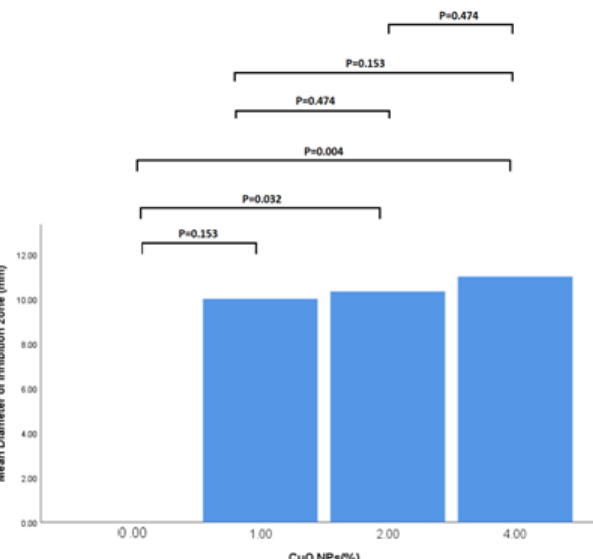
Figure 5. The results of the pairwise comparison test on the groups for addition of CuO NPs into the GIC.